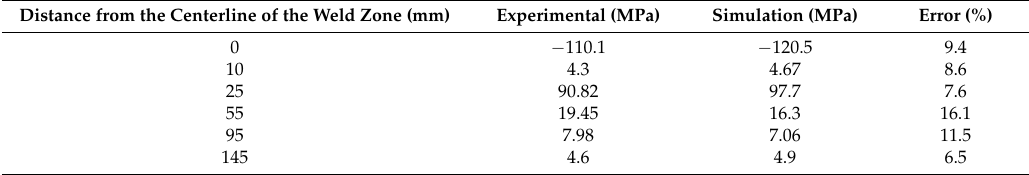
Table 5. Values of the principal stresses in Y direction obtained from simulation and experiment.